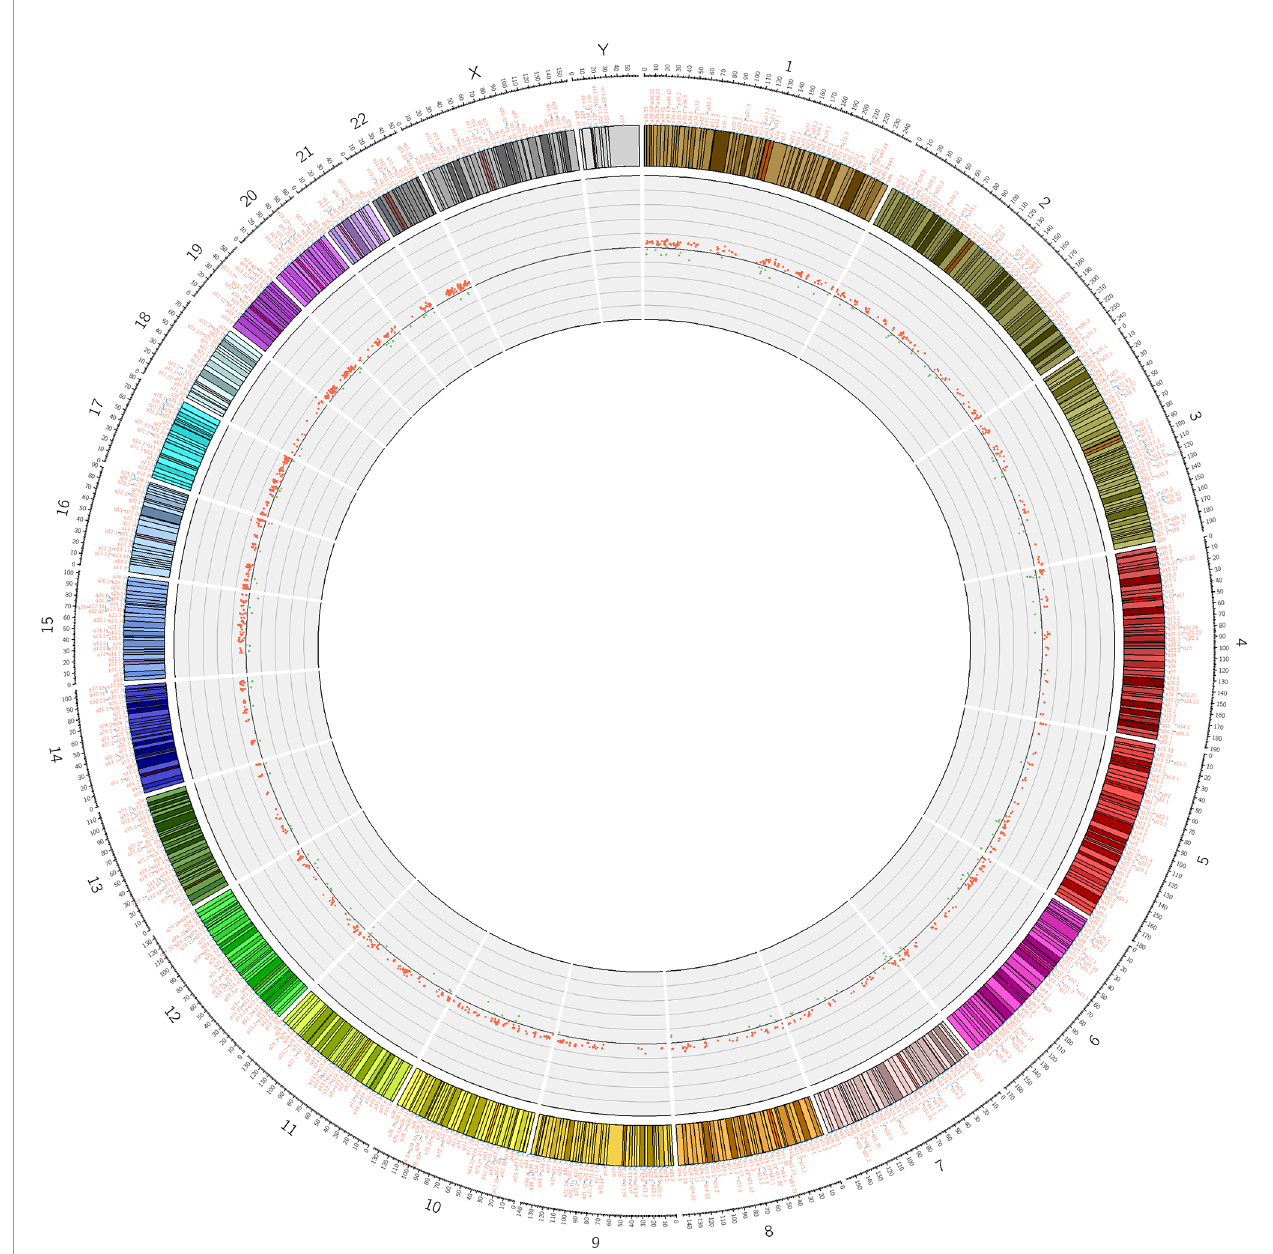
FIGURE 2 | Differential methylation site (P <5.92 E-08) circos diagram. The distribution of 1530 differential DNA methylation sites on 22 chromosomes, the outer layer is the physical location of the chromosome; the middle layer is the chromosome segment; the inner layer is the methylation of the site, red indicates hypermethylation, and green indicates